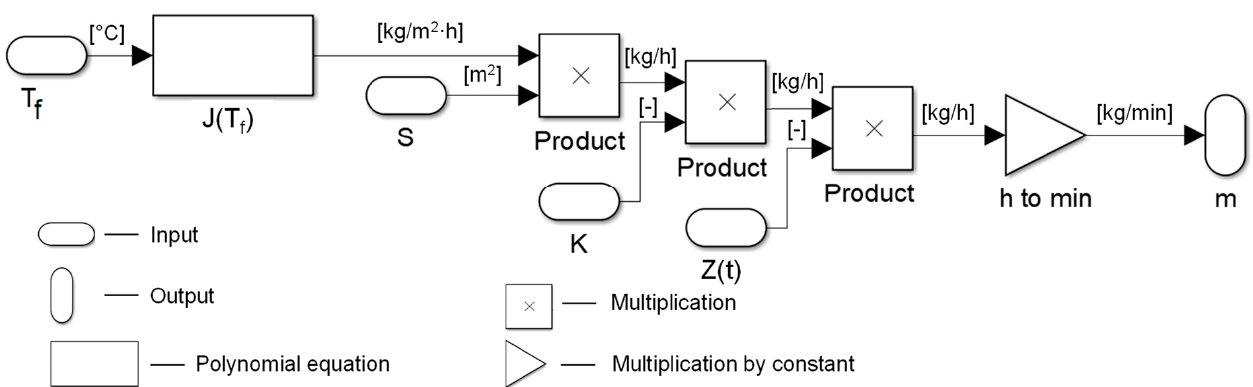
Figure 3. Representation of the membrane module in Simulink: m is the amount of water evaporated in MD module per minute [kg/min], J(T f ) is the polynomial equation that defines the flux of distilled water as a function of the feed Table 2 [kg/m 2 · h]; T f is the feed temperature [ ◦ C]; S is the active surface area of one membrane module [m 2 ], K is the number of membrane modules, Z(t) is the nonlinear function describing the deterioration of membrane performance due to scaling/fouling over time.